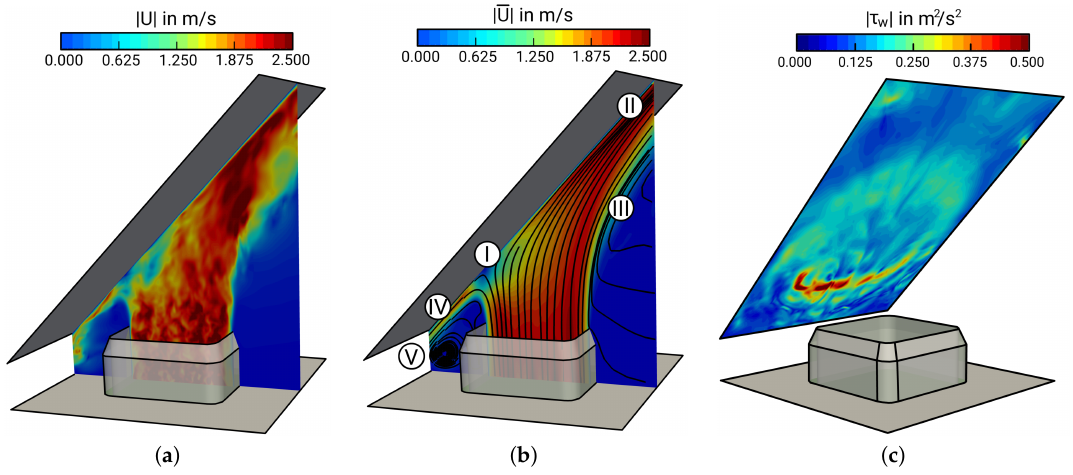
Figure 2. Instances of: ( a ) instantaneous magnitude velocity at the mid-plane section; ( b ) time- averaged magnitude velocity at the mid-plane section with superimposed streamlines of mean velocity; and ( c ) time-averaged absolute shear stress induced by the inclined jet on the impinged